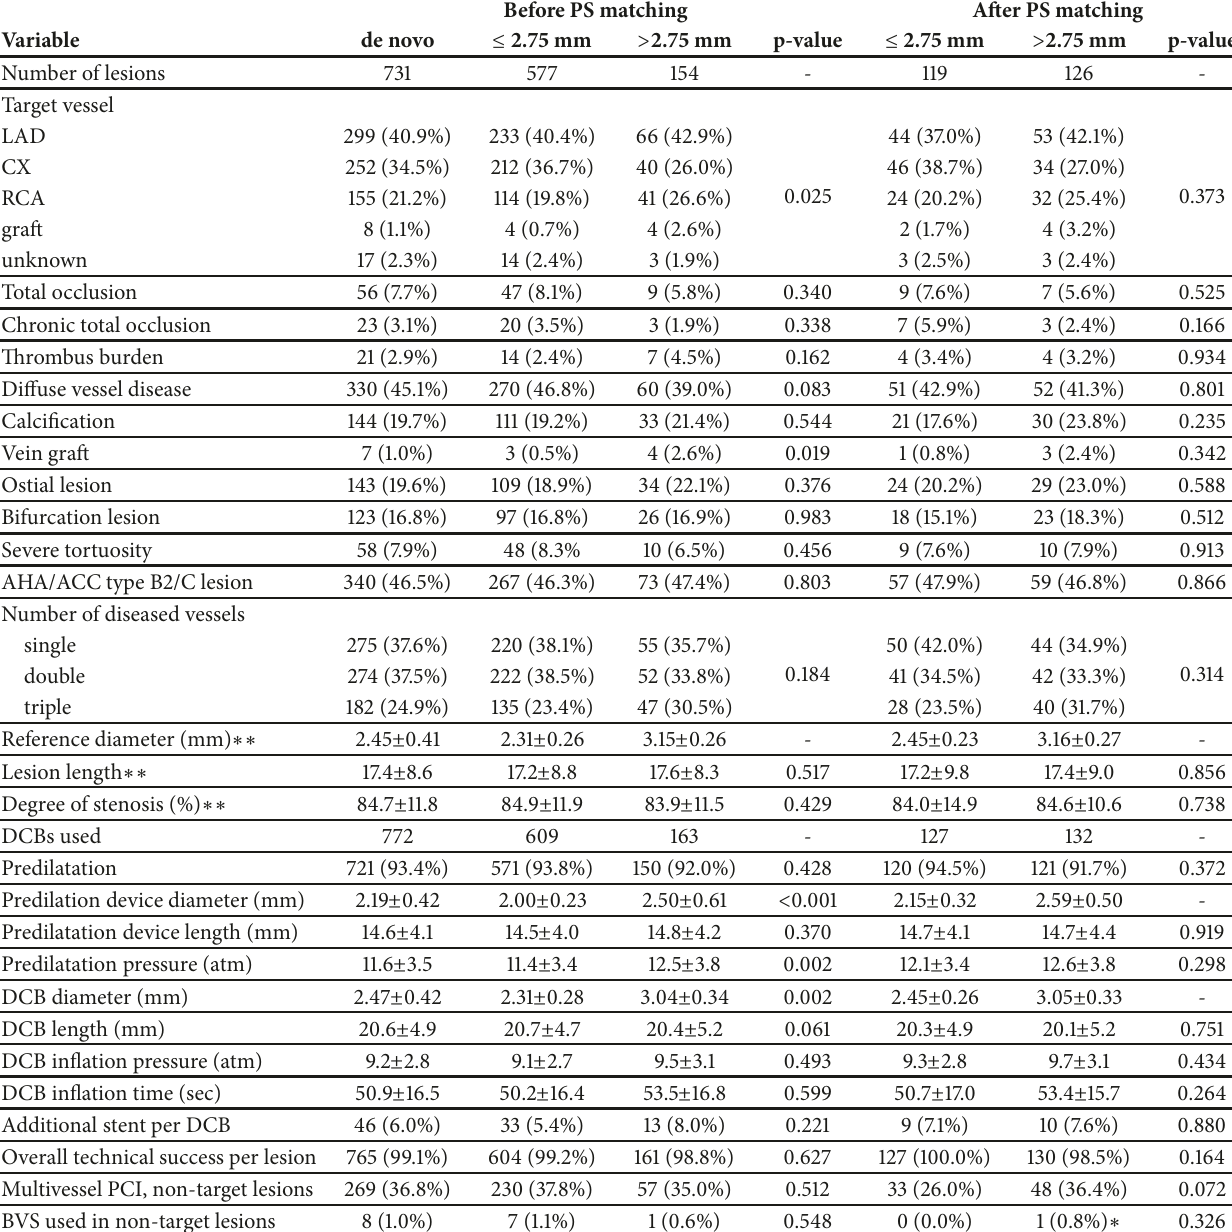
Table 2: Lesion characteristics, procedural data, and device